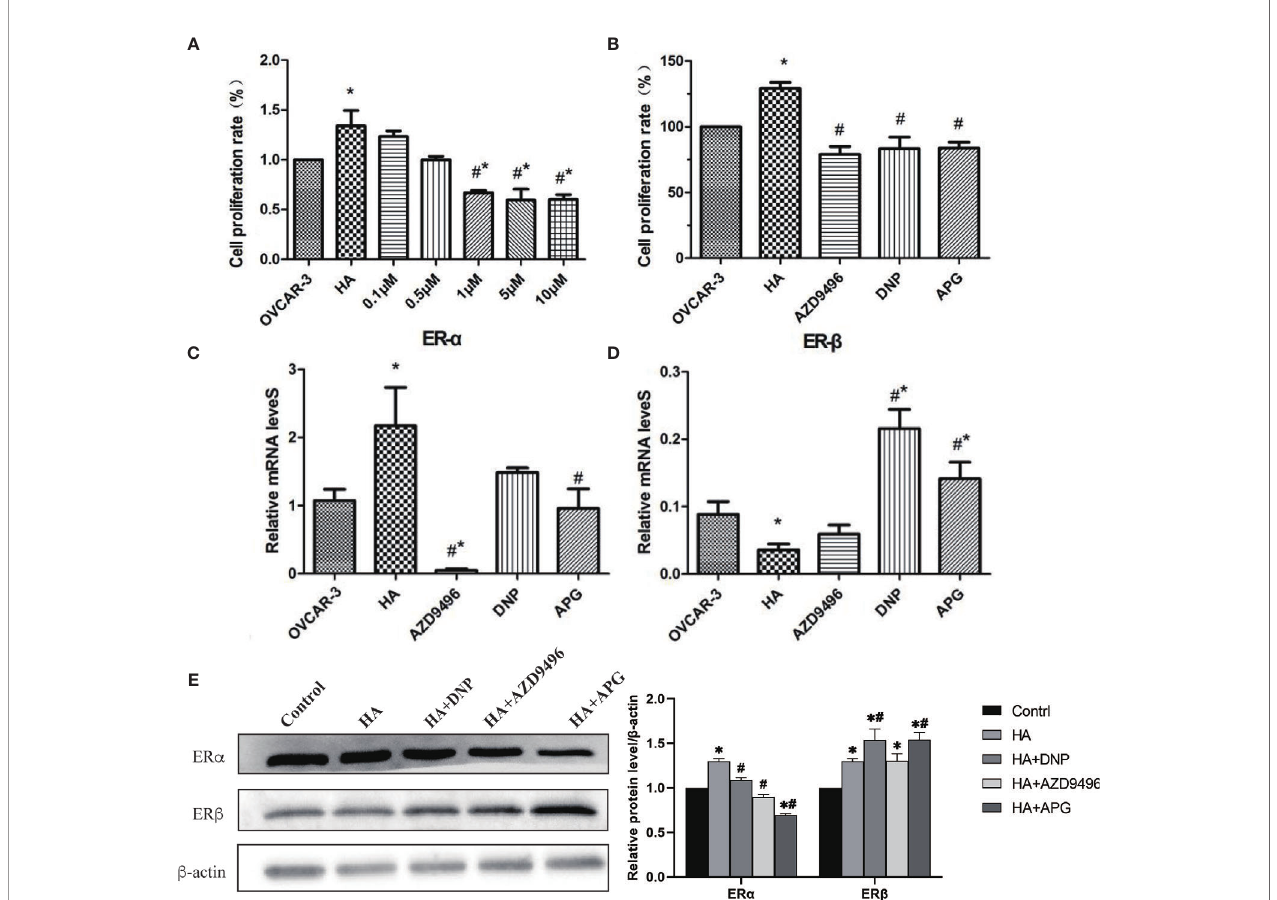
FIGURE 4 | Apigenin inhibits the tumor-promoting effect of histamine by down-regulating ER a /ER b . (A, B) The effect of different concentrations of apigenin, AZD9496, and DNP on the proliferation of OVCAR-3 cells. The concentration of AZD9496 and DNP was 1 µM. (C, D) The mRNA expression of ER a (C) and ER b (D) . (E) The protein expression of ER a and ER b by western blot. * P < 0.05 (Compared to untreated OVCAR-3 cell group); # P < 0.05 (compared with the HA-treated